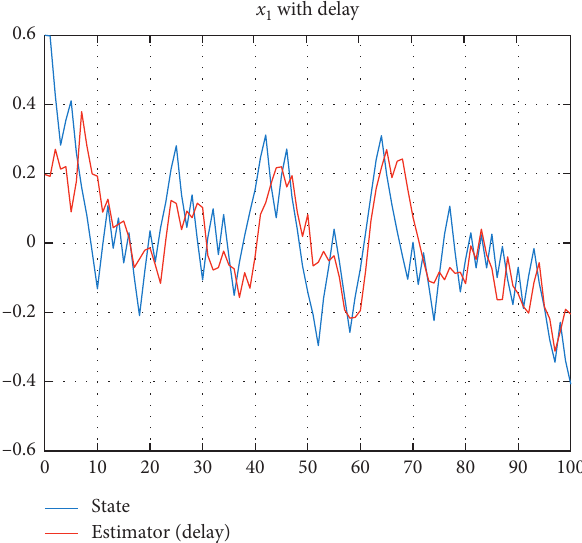
( k ) and the filter 􏽢 x ( k | k ) 1